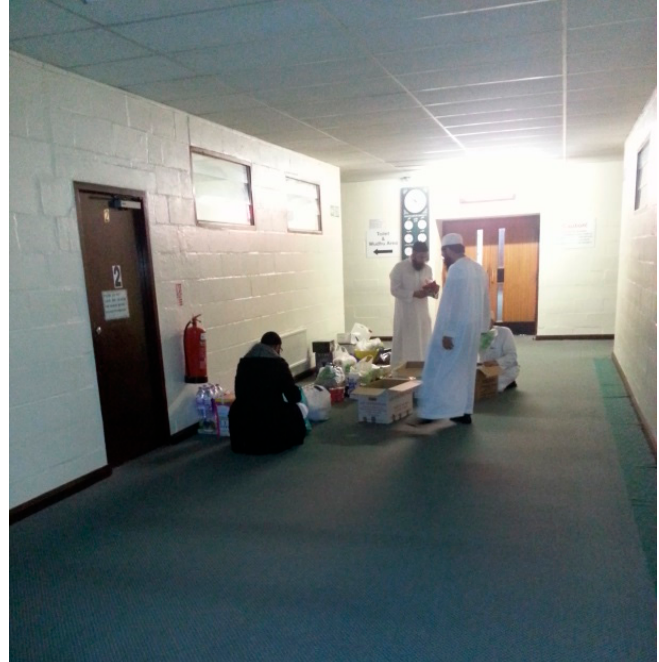
Figure 4. A young British-born TJ group packing their provisions in Dewsbury before departing on an international 40-day TJ excursion in November 2013. Source: author’s photo.